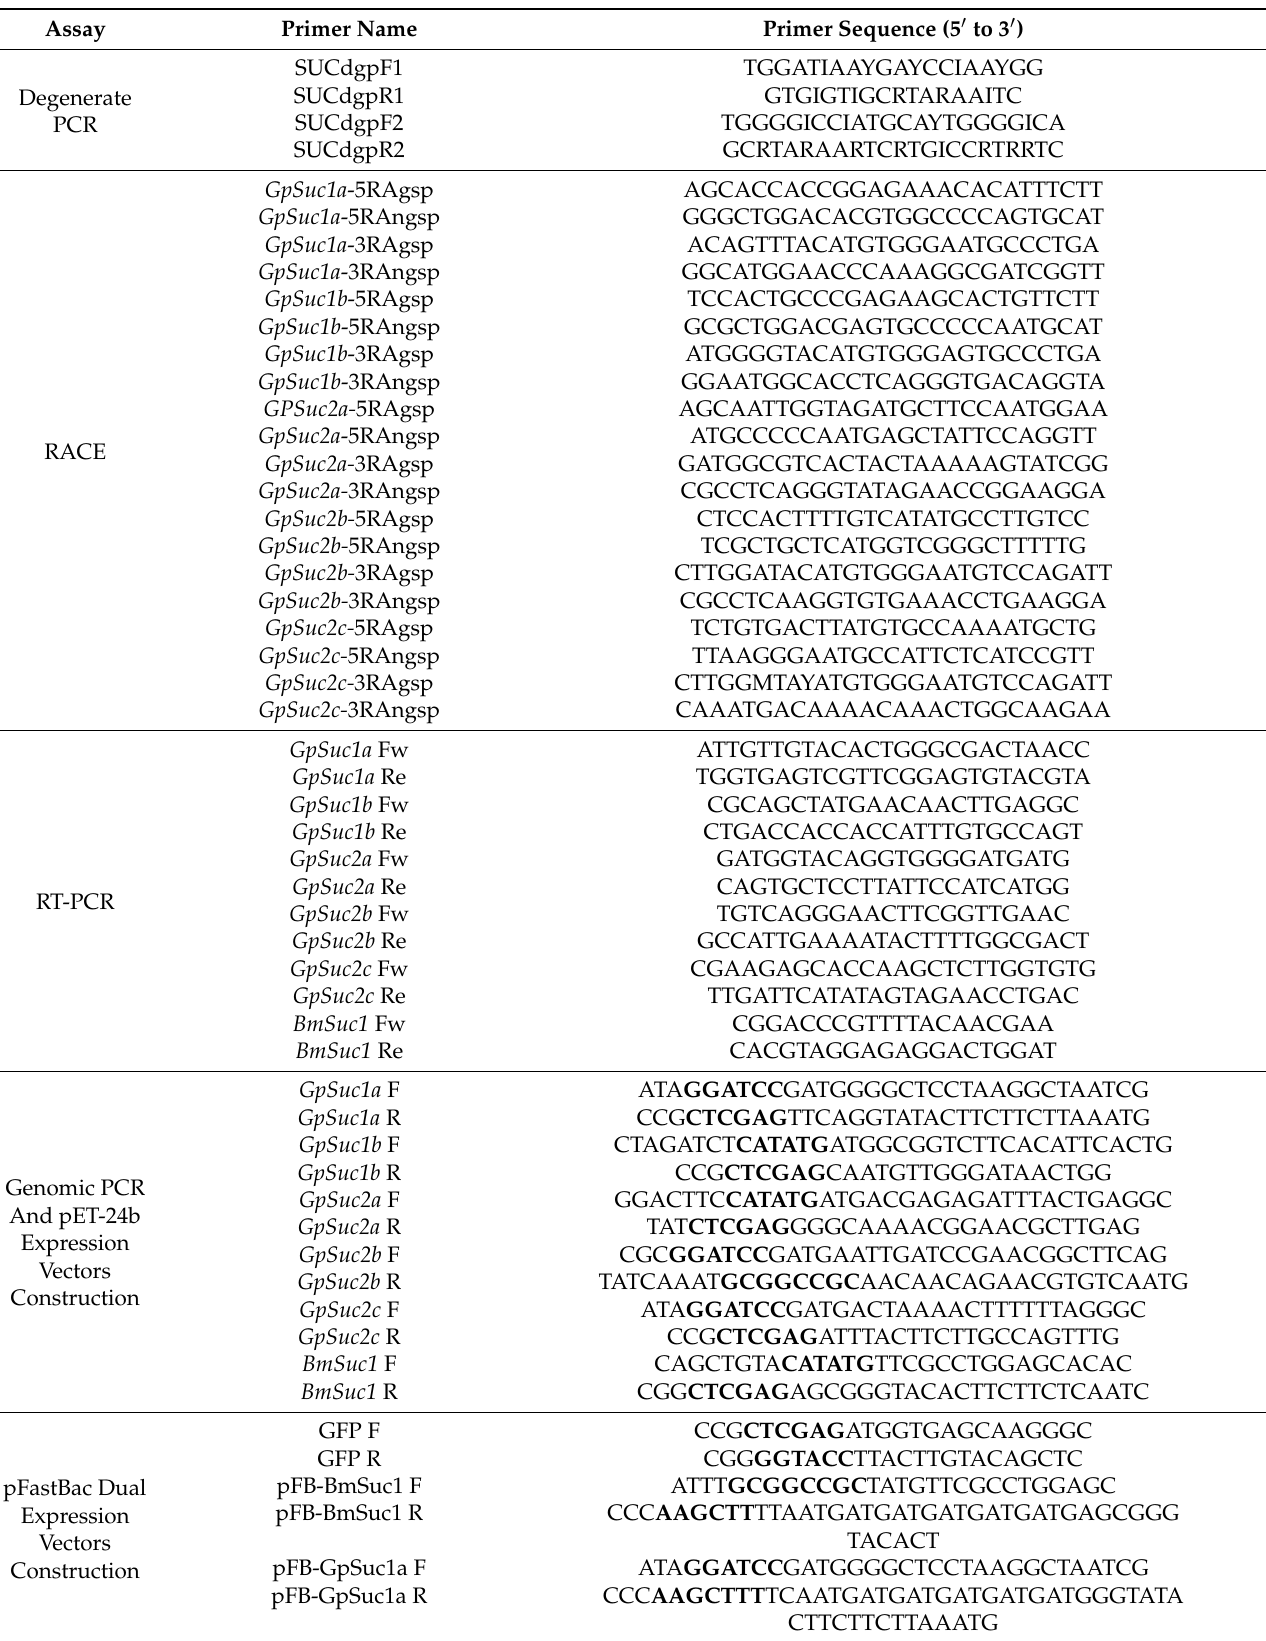
Table 1. The primer sequences used in this